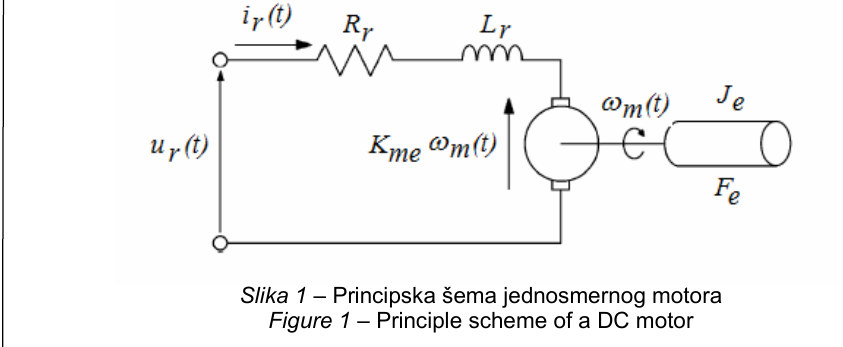
Figure 1 – Principle scheme of a DC